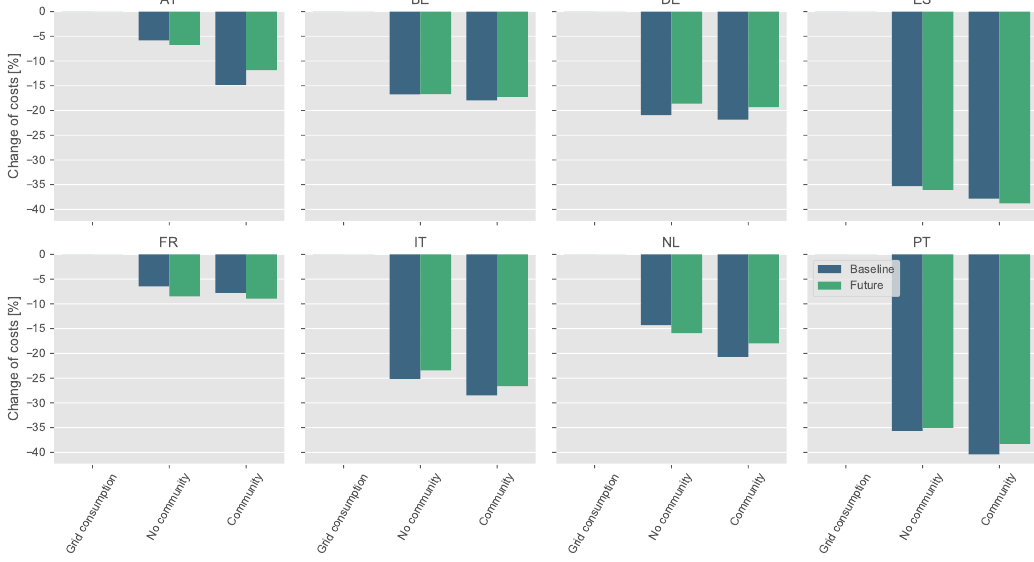
Figure 10. Change of total costs in relation to demand scenario grid